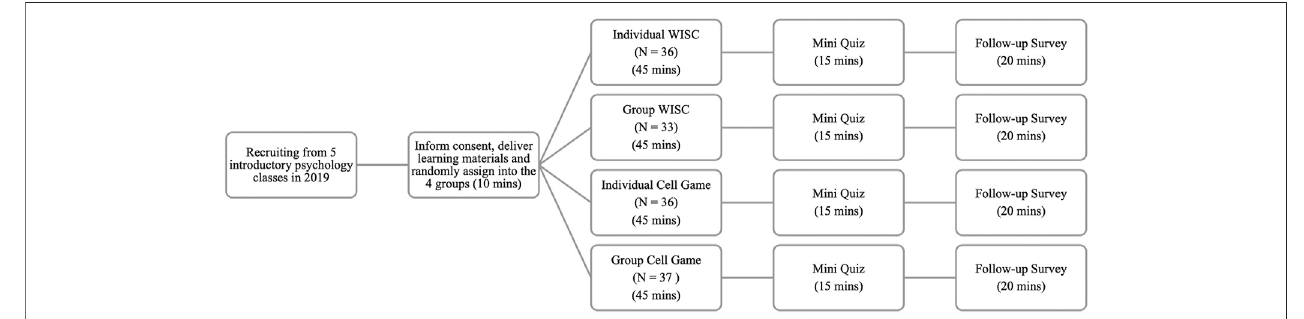
FIGURE 2 | Flow chart of the study procedure.